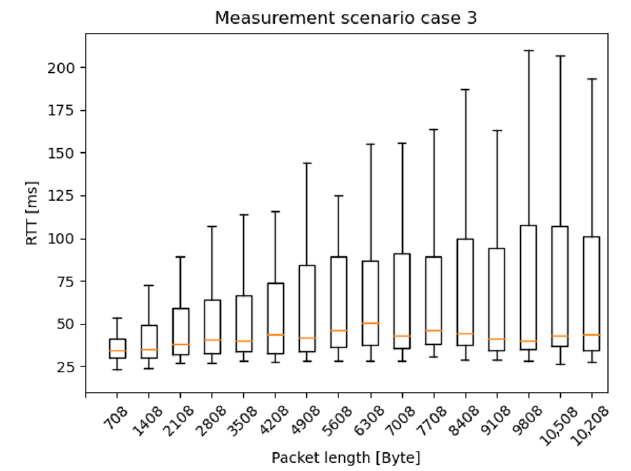
Figure 15. RTT results with different packet lengths—scenario 3: from 10 ms IAT and 700 Byte PL, to 610 ms IAT and 11,200 Byte PL, increment the PL by 700 Byte for every iteration and the IAT by 200 ms for every fourth